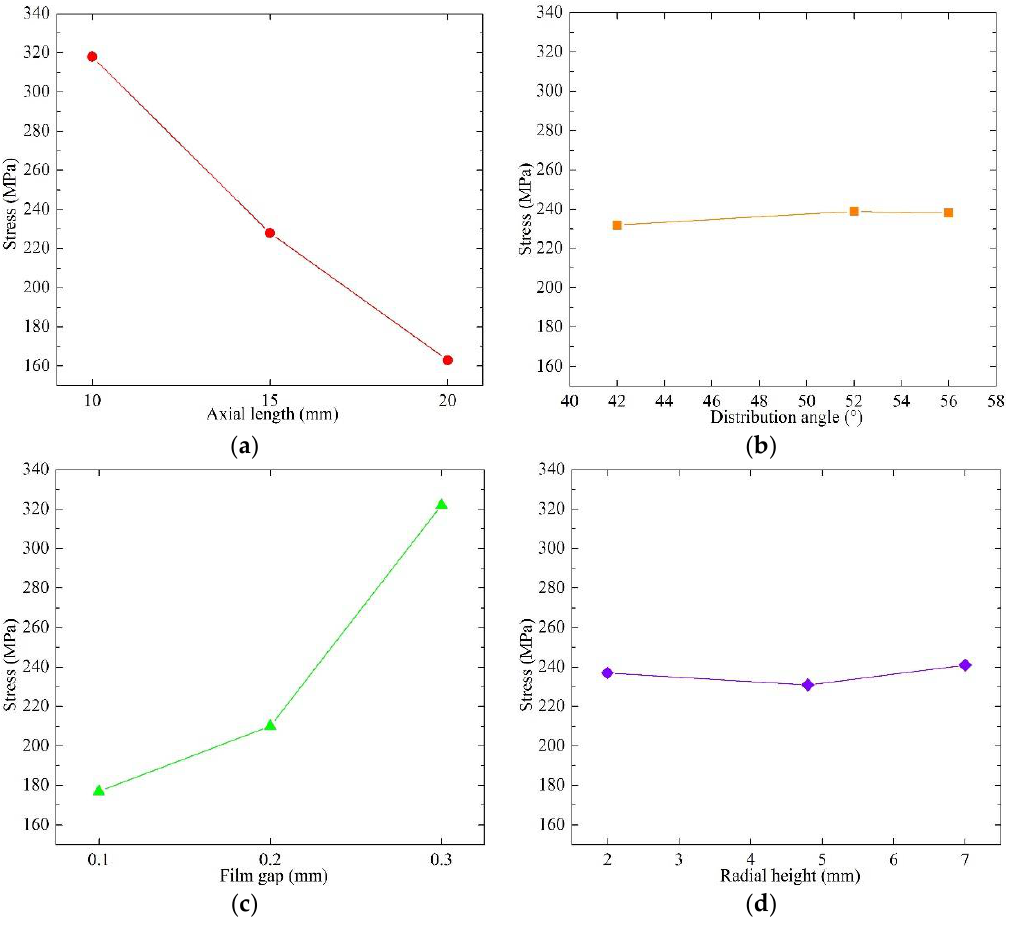
Figure 12. Main effect for stress: ( a ) Axial length; ( b ) Distribution angle; ( c ) Film gap; ( d ) Radial height.